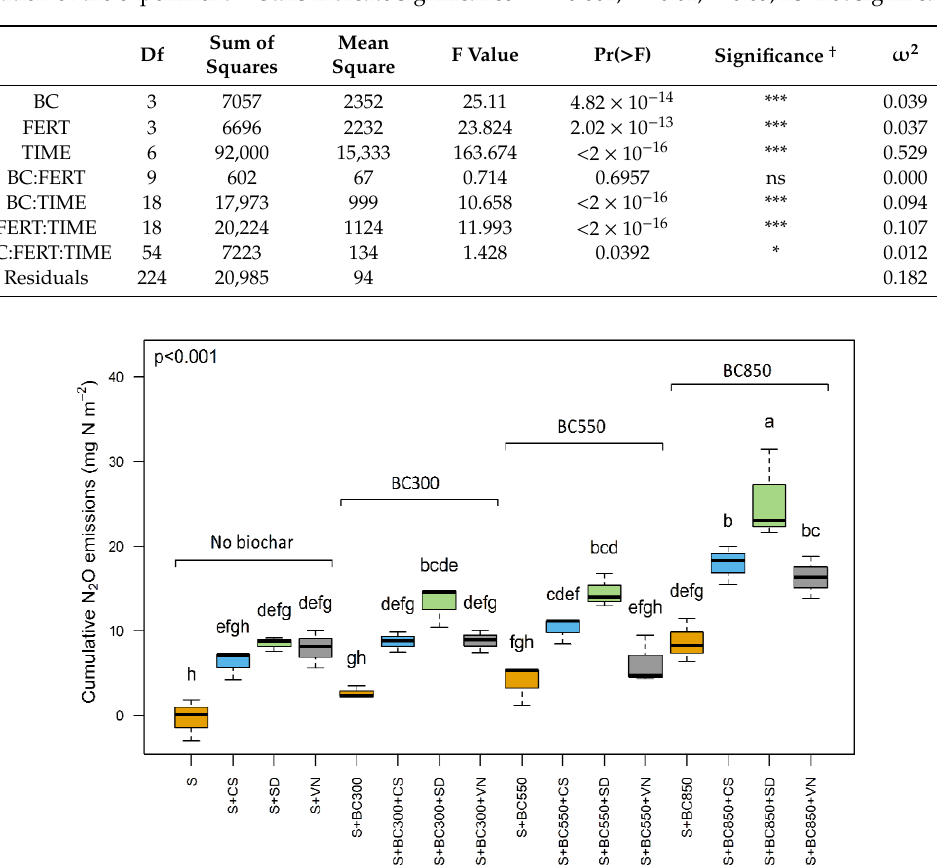
Figure 1. Total cumulative N 2 O fluxes (mg N m − 2 ) for each treatment (S: Soil; BC300: biochar produced at 300 °C; BC550: biochar produced at 550 °C; BC850: biochar produced at 850 °C; CS: cattle slurry;